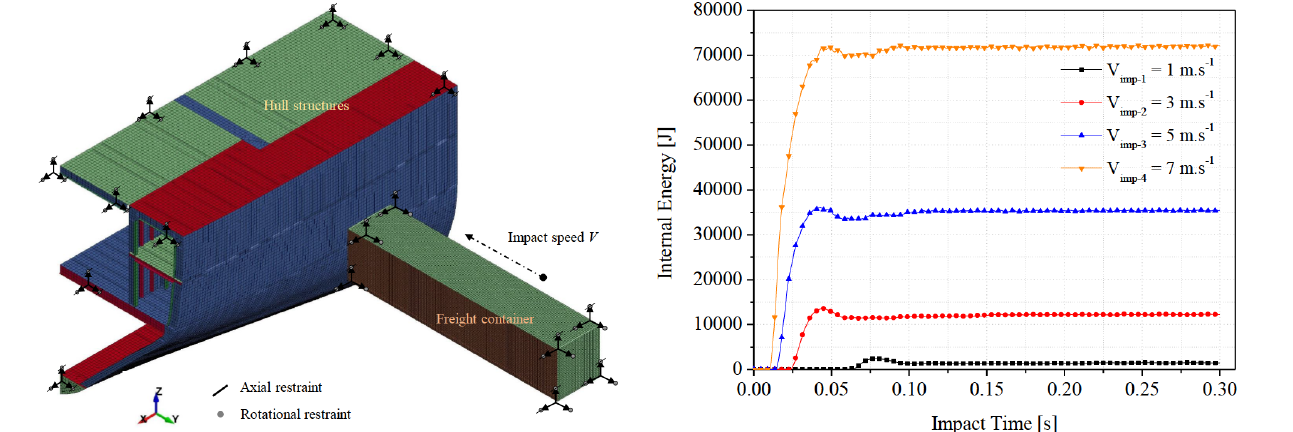
Figure 6: Internal energy of a variety collision speed. The energy indicated an amount to plastically deform both entities in collision